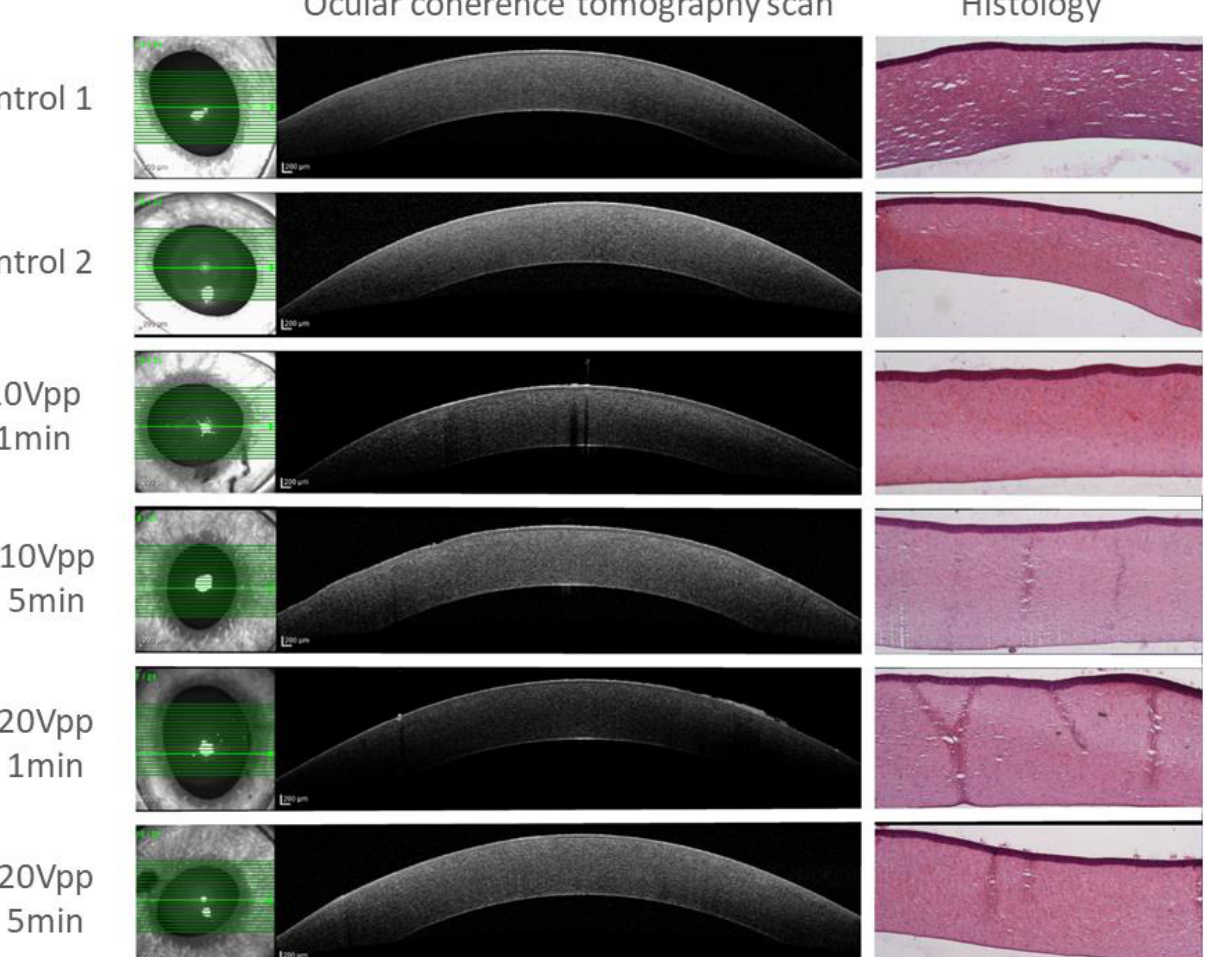
Figure 6. Post-treatment imaging and histology for various wave amplitudes and durations. No signs of adverse effects of the acoustic waves on the corneal endothelium or stroma compared to controls were detected.